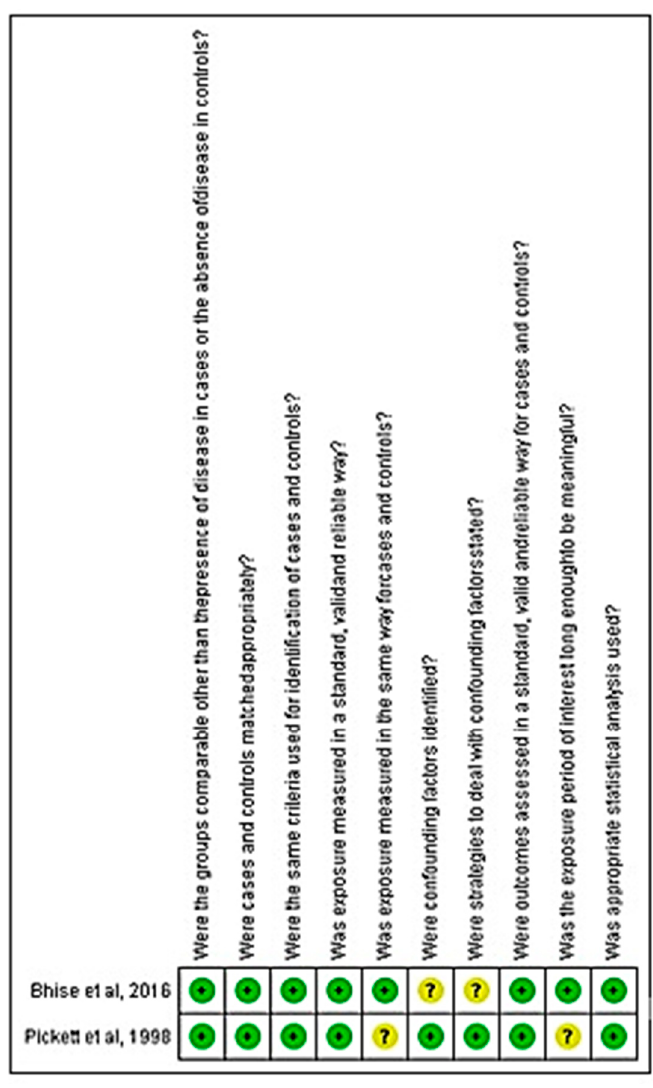
Figure 3. Analysis of the risk of bias for the case-control study included in the review.